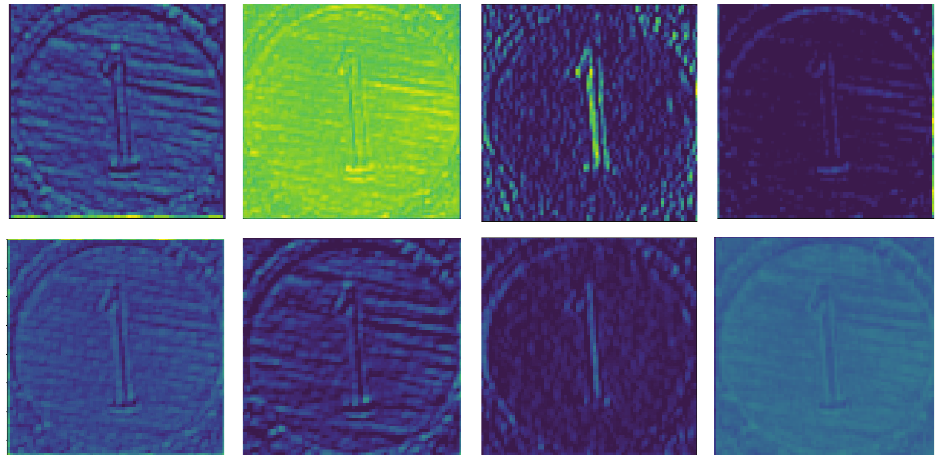
Figure 6. Visualization of 8 channels randomly selected in the first convolutional layer of VGG-16 trained on our dataset. Different channels reflect different information about the input